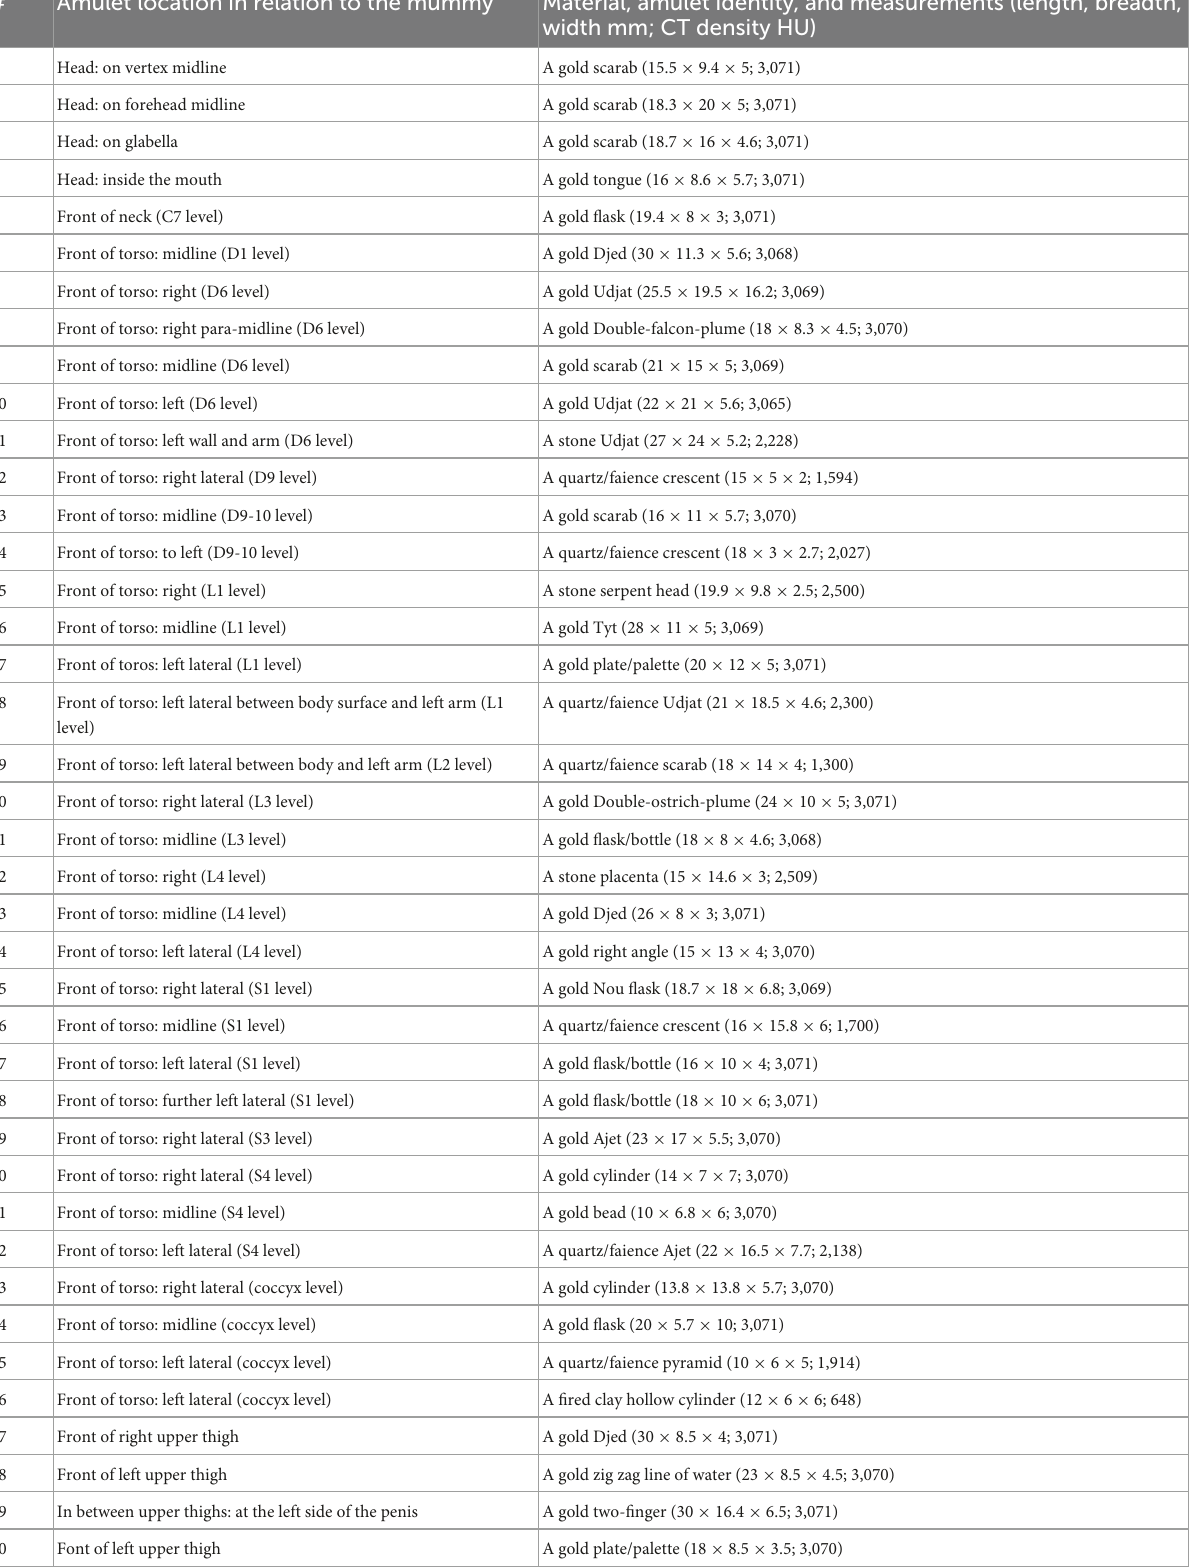
TABLE 1 Computed tomography (CT) findings of amulets related to the